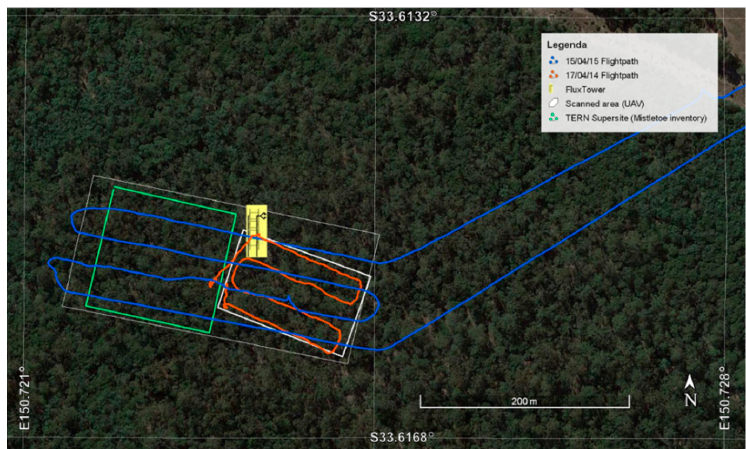
Figure 1. Flight track of two flights, illustrating the difference in flight track with the two UAV systems used. Map created with Google Earth Pro (Google LLC., Mountain View, CA, USA).